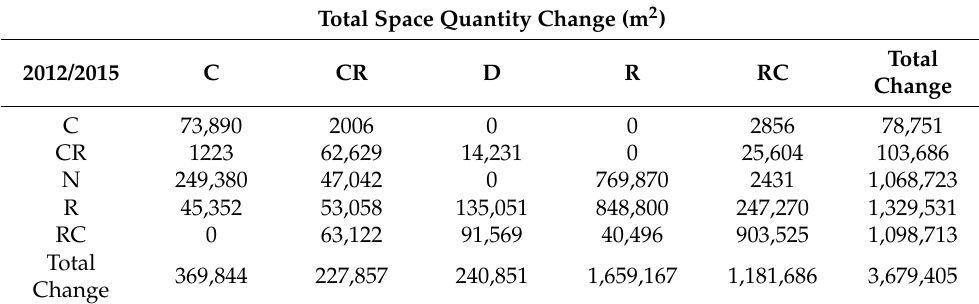
Table 5. Total space quantity change from 2012 to 2015 in Jiang’an district by Parcel type.